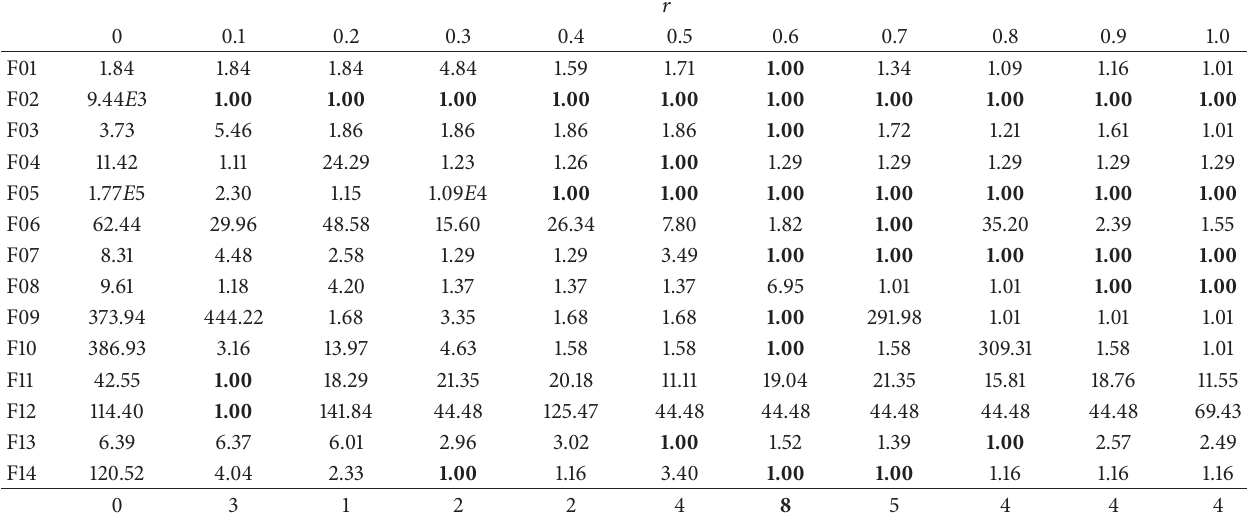
Table 7: Best normalized optimization results in fourteen benchmark functions with different 𝑟 . The numbers shown are the best results found after 100 Monte Carlo simulations of HS/BA